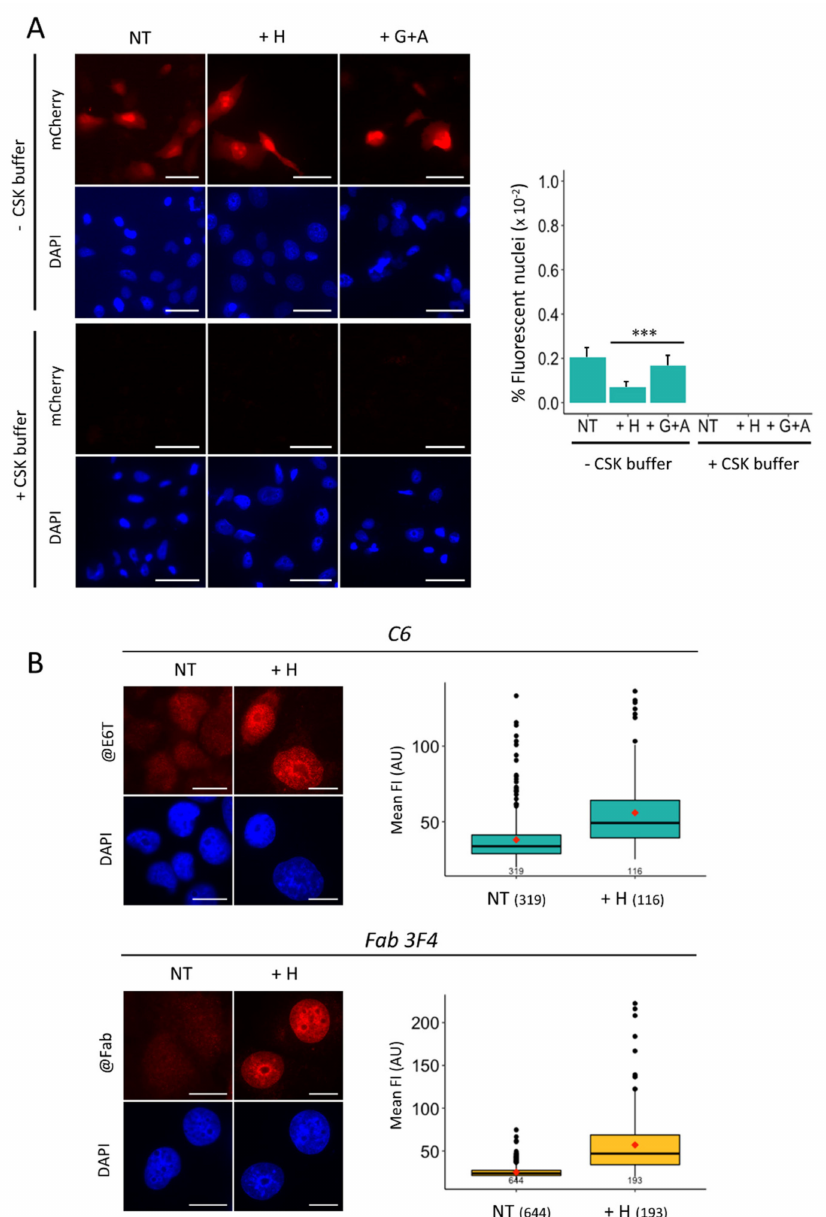
Figure 3. C6 nanobody localization to the nucleus in drug-treated H1299 cells. ( A ) Immunofluores- cence analysis of H1299 cells after transfection with the plasmid encoding the C6-mCherry chromo- body. 24 h post-transfection, the indicated drugs (H, hydroxyurea; G+A, gemcitabine + AZD-7762) were added. After incubation for 24 h, the cells were either fixed (- CSK buffer) or washed with CSK buffer prior to fixation (+ CSK buffer). The nuclei were counterstained with DAPI (blue). The panel shows representative images recorded under the microscope (left) and the percentage of fluorescent cells observed in each condition is shown (right). Cut-off for negative cells was set on non-transfected cells using the maximal recorded value. Data are represented as mean ± SEM, *** p < 0.001. Scale bar: 50 µ m. NT, untreated cells. ( B ) Following transduction with either C6 nanobody or Fab 3F4, H1299 cells were treated with H and analyzed by immunofluorescence 48 h post-treatment. Representative images are shown on the left. Bound nanobody or Fab were re- vealed with anti-E6 tag antibodies (anti-E6T) and secondary Alexa 568-labelled anti-mouse globulins (anti-IgG). Scale bar: 20 µ m. The quantification of the γ -H2AX mean fluorescence intensity (FI) of the monitored cells is shown on the right. The numbers indicated in brackets correspond to the number of cells analyzed in each